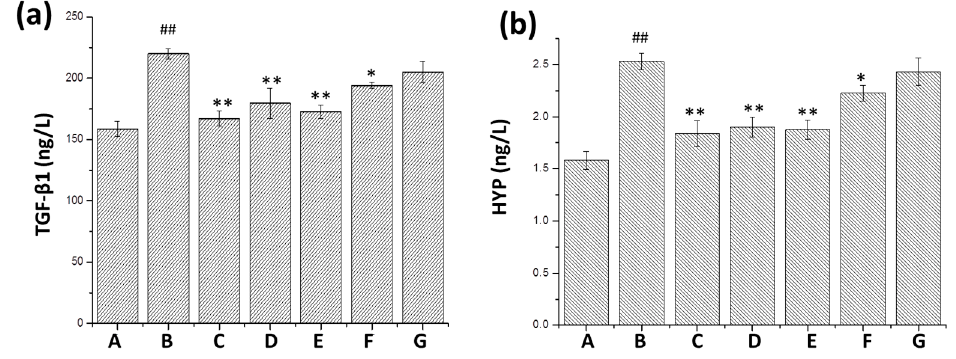
Figure 6. Cont. Figure 6.